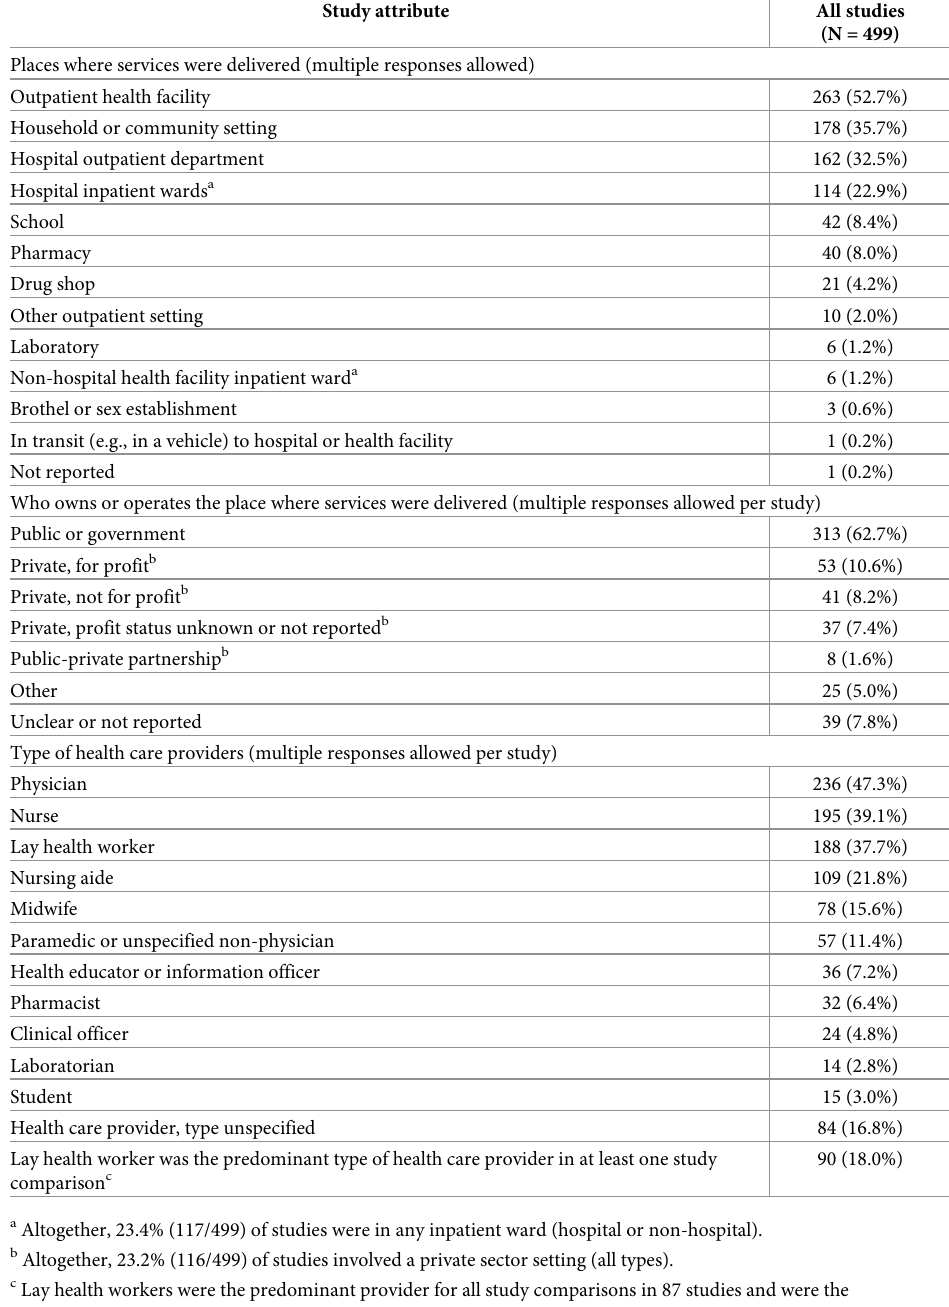
Table 4. Study setting: Places where services were delivered, who owns or operates the service delivery points, and types of health care